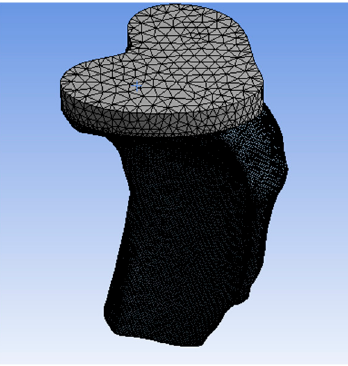
Figure 6. Mesh structure of the FEA model.